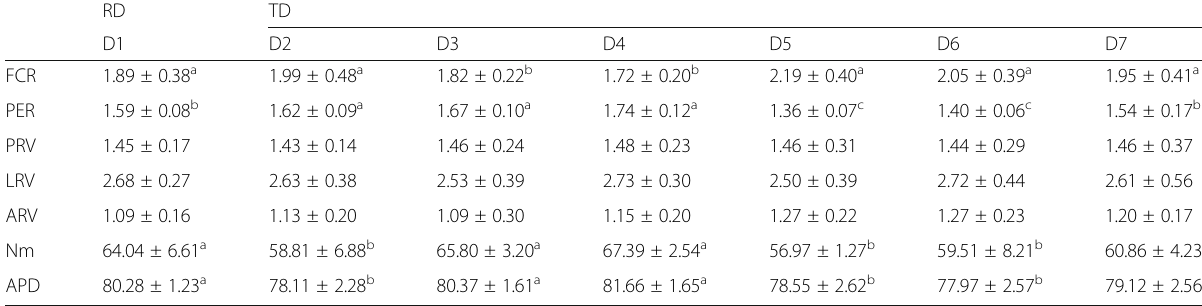
Table 4 Feed utilisation parameters of L. rohita fingerlings after 100 days of